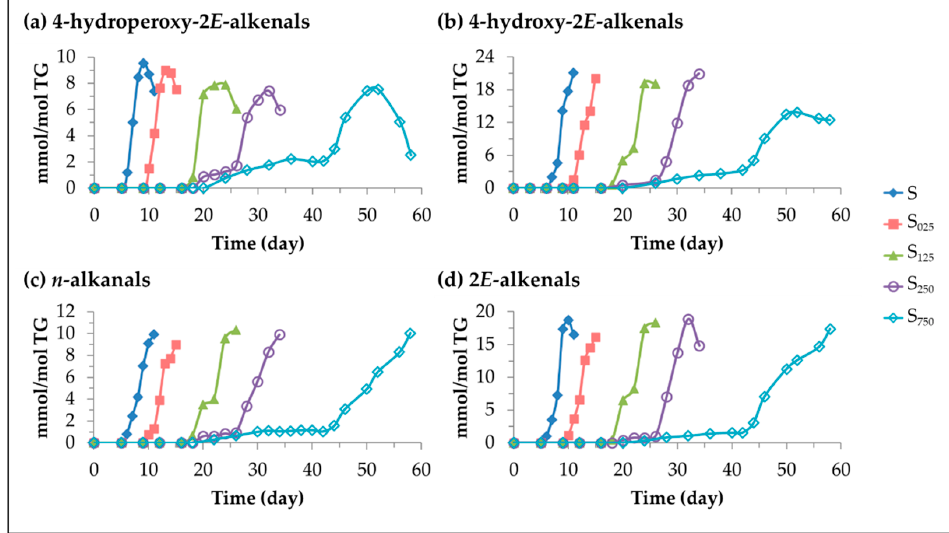
Figure 12. Evolution of the concentration, expressed in mmol/mol TG, in samples S, S 025 , S 125 , S 250 and S 750 throughout the storage time, up to a very advanced oxidation stage of: ( a ) 4-HPO-2 E -alkenals; ( b ) 4HO-2 E -alkenals; ( c ) n -alkanals; and ( d ) 2 E -alkenals.